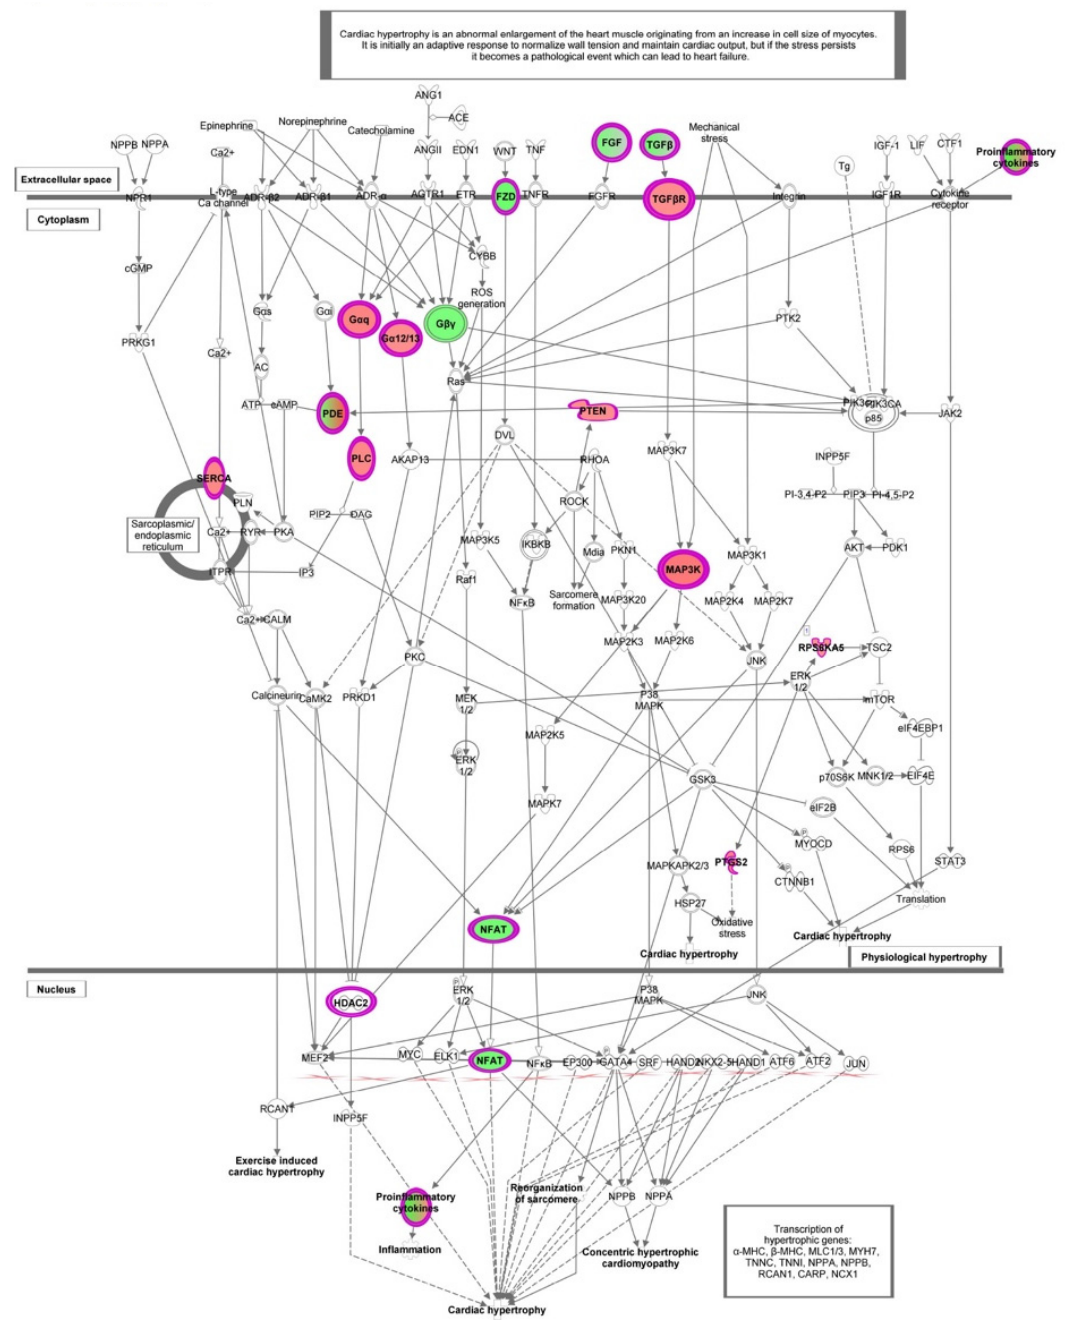
Figure 7. Canonical pathways representing “Cardiac hypertrophy signaling (enhanced)” obtained with Ingenuity Pathway Analysis (IPA) from the analysis of data set modulated by HT in IL-1 β stimulated HUVECs. Genes which expression was significantly modulated by HT are depicted together with others involved in the cascade (but not significantly modulated, depicted in gray). Complex or groups of genes are surrounded by a double line. Up-regulated genes are depicted in red, and down ‐ regulated genes are depicted in green.